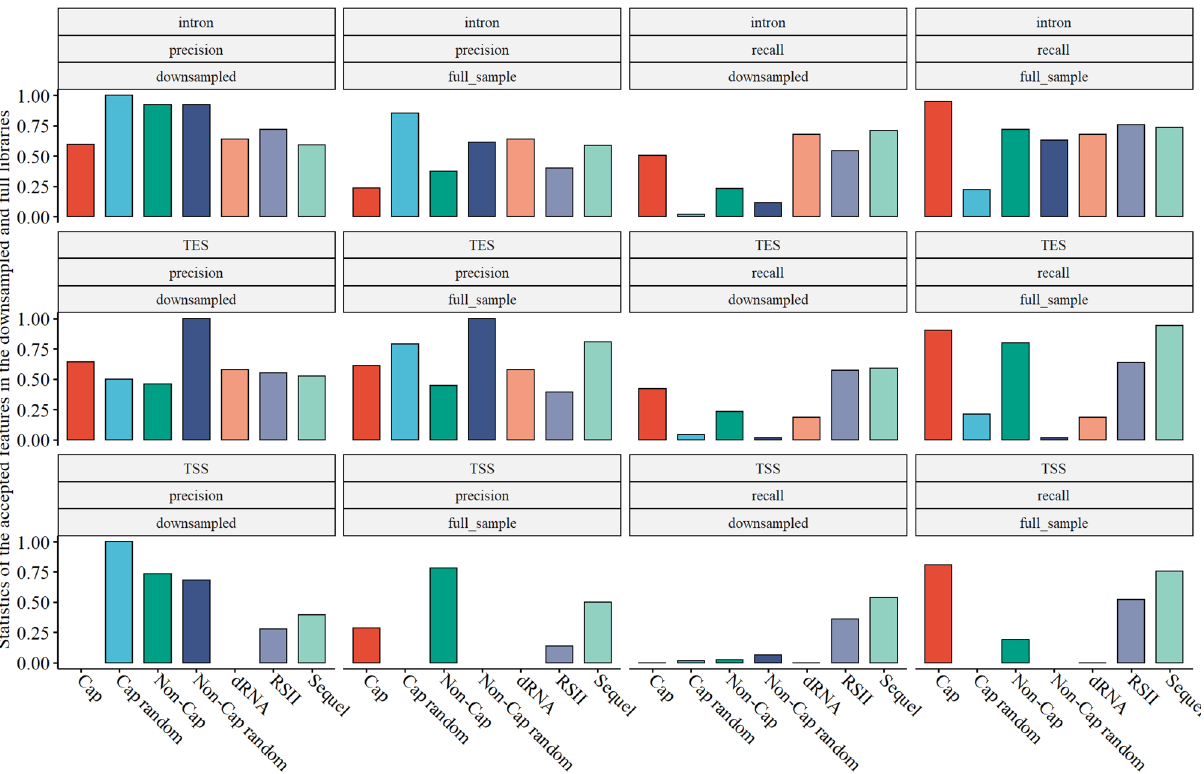
Figure 3. Effect of downsampling on the recall and precision of the detection of the high-confidence features (introns, TESs and TSSs) in the different sequencing methods and library preparations. The features were termed high-confidence if they passed the stringent filtering criteria. Recall was calculated as the ratio of high- confidence features that was found in the respective samples, while precision was calculated as the ratio of true positives in all the hits of respective samples. The downsampling of reads were carried out to match the sizes of the libraries to the size of the smallest library